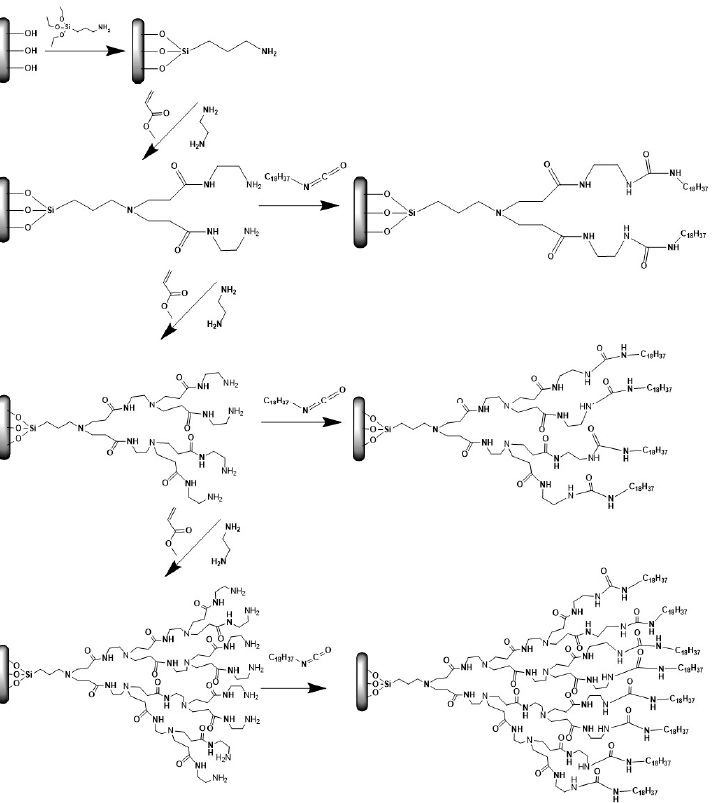
Figure 14. Formation of PAMAM dendrons on silica surface and generation of amphiphilic dendron surface-modified silica after functionalization of amino-end groups with octadecylisocyanate (Reproduced with permission from [97]; Copyright American Chemical Society, 2008).